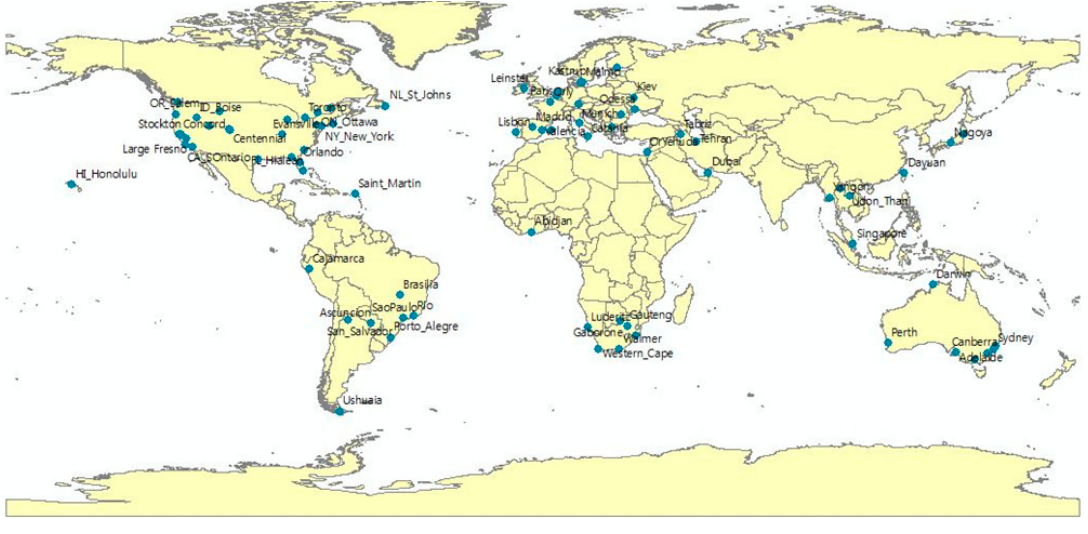
Figure 5. Level 1 site locations.